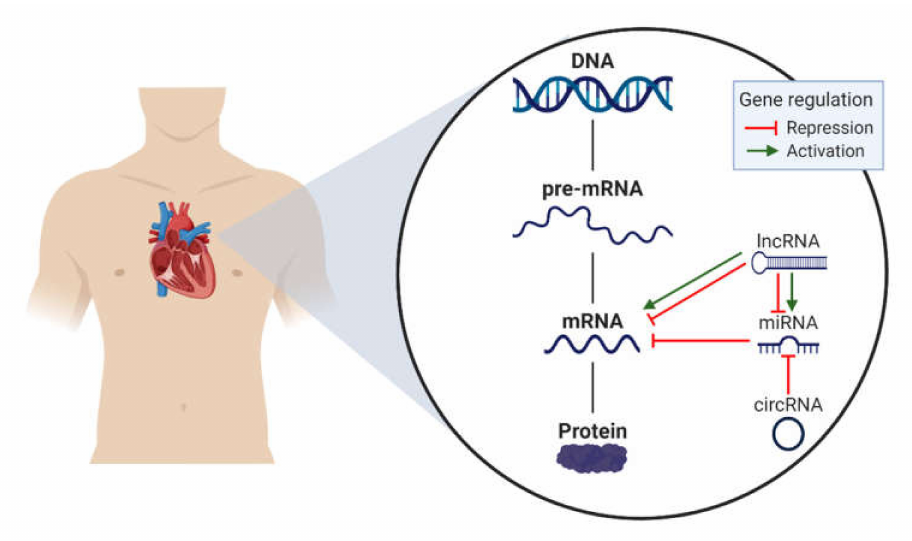
Figure 1. Non-coding RNA regulation. Legend: mRNA, messenger RNA; lncRNA, long non-coding RNA; miRNA, microRNA; circRNA, circular